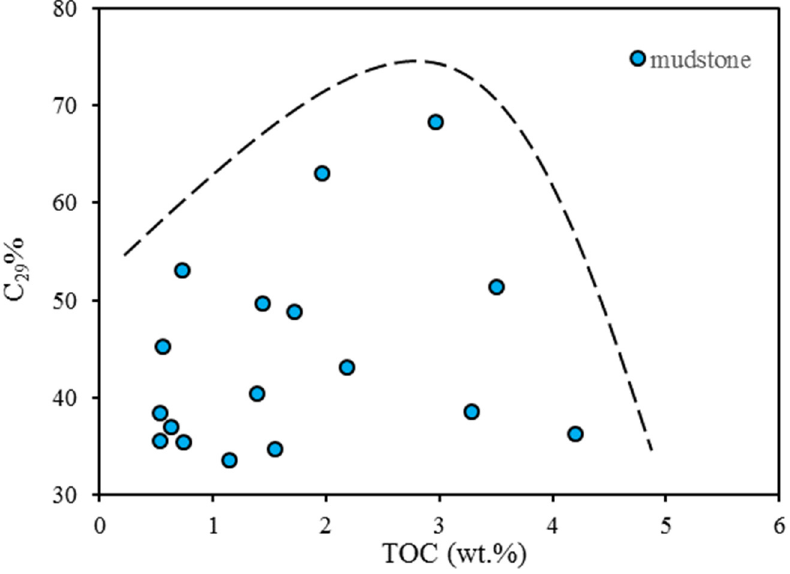
Figure 13. Relationship between C 29 sterane content and TOC for dark mudstone.